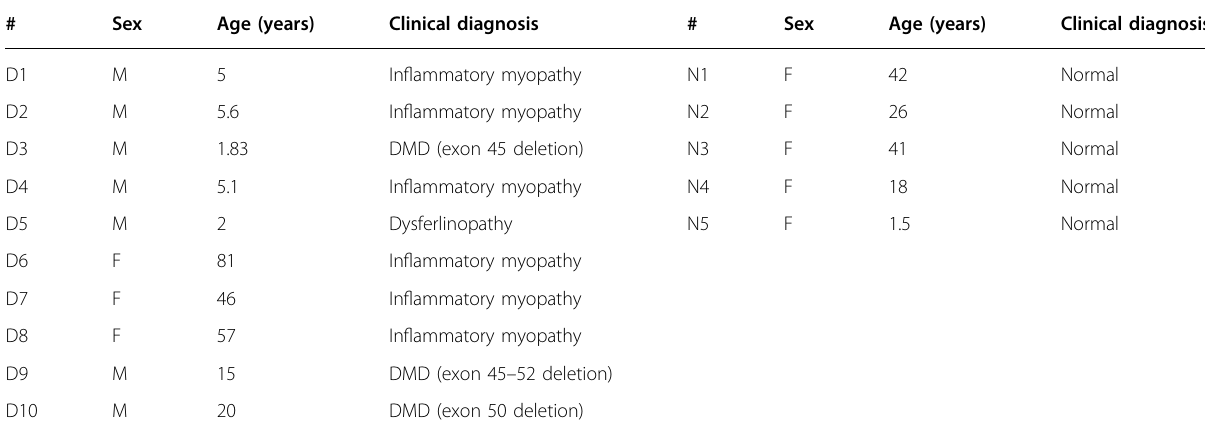
Table 1 Information on patients with myopathy and normal